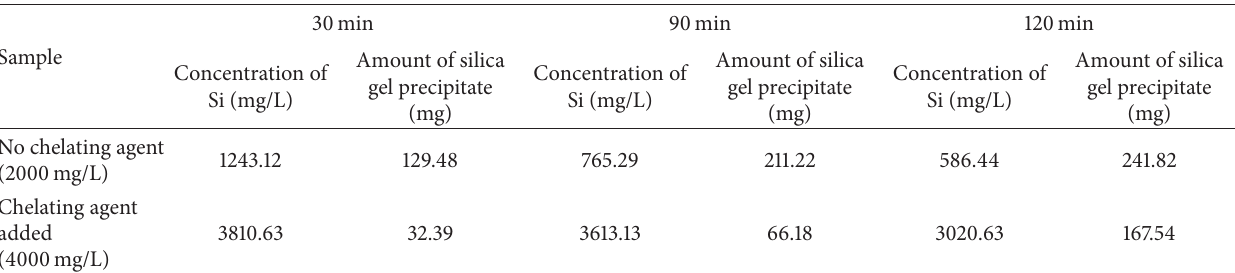
Table 4: Chelating agent’s effect on silica gel precipitate.